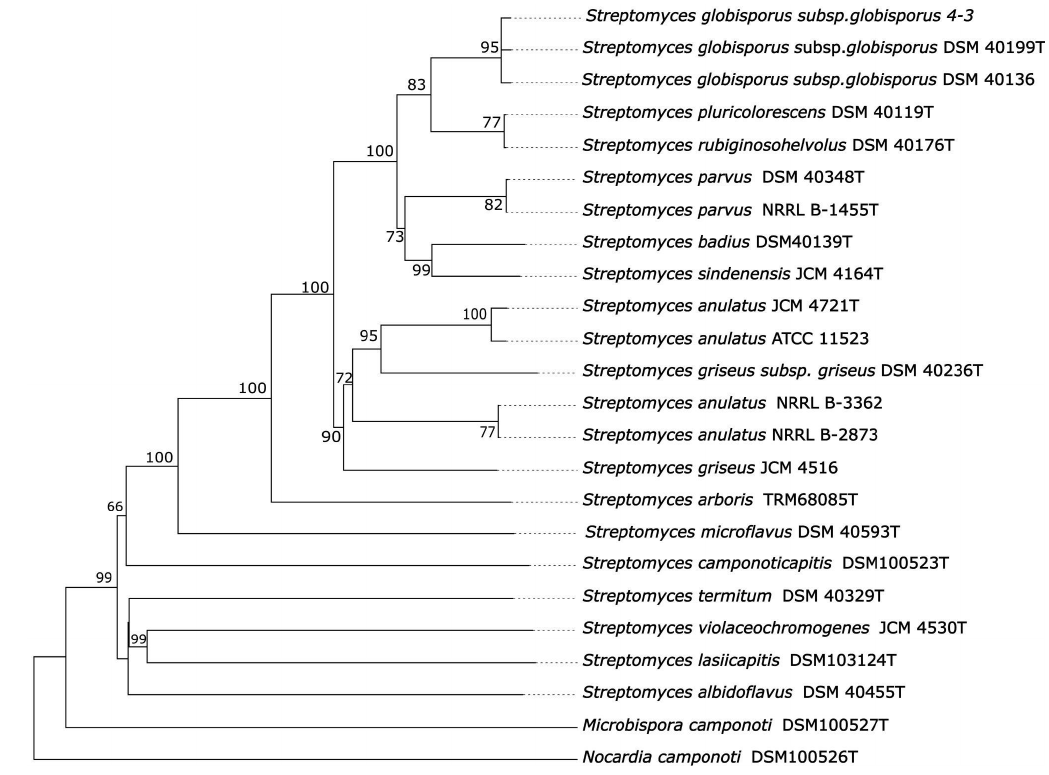
Figure 1. Phylogenetic tree based on whole-genome sequences from 4-3, related type strains and actinobacteria isolated from ants. The branch lengths are scaled in terms of GBDP distance formula d5. Numbers above branches are GBDP pseudo-bootstrap support values > 60% from 100 replications, with an average branch support of 81.4%. Nocardia camponoti DSM 100526 T as outgroup [27]. Table 1. Genome relatedness of 4-3 and Streptomyces